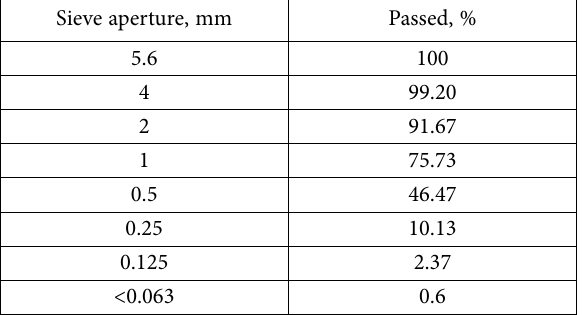
Table 4. Sand particle size distribution Sieve aperture, mm